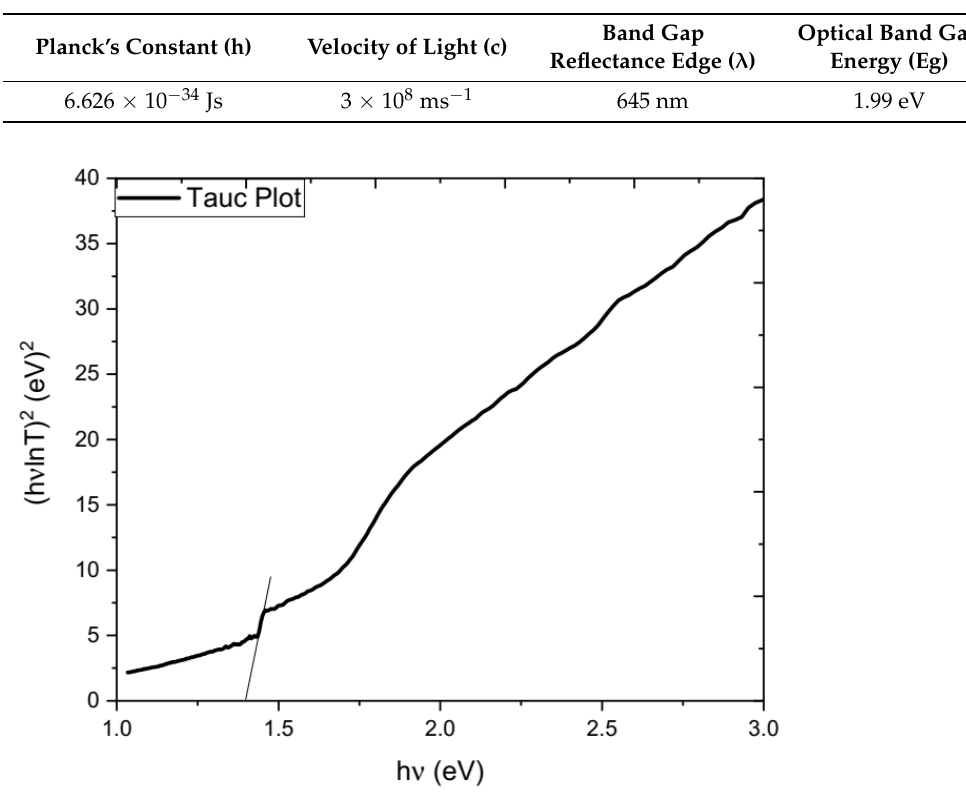
Table 2. Optical band gap energy of NiO NPs.